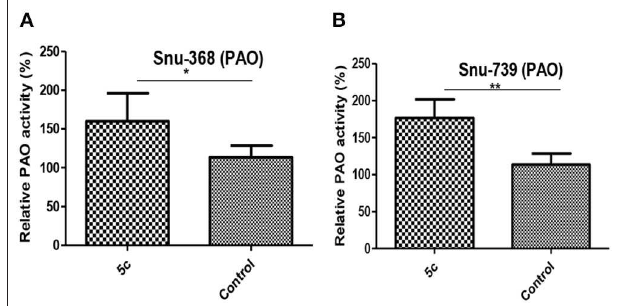
FIGURE 7 | Effect of 5c on PAO expression in Snu-368 (A) and Snu-739 (B) cells with 10 µ M after 24h treatment. ** P < 0.05; ** P < 0.01.